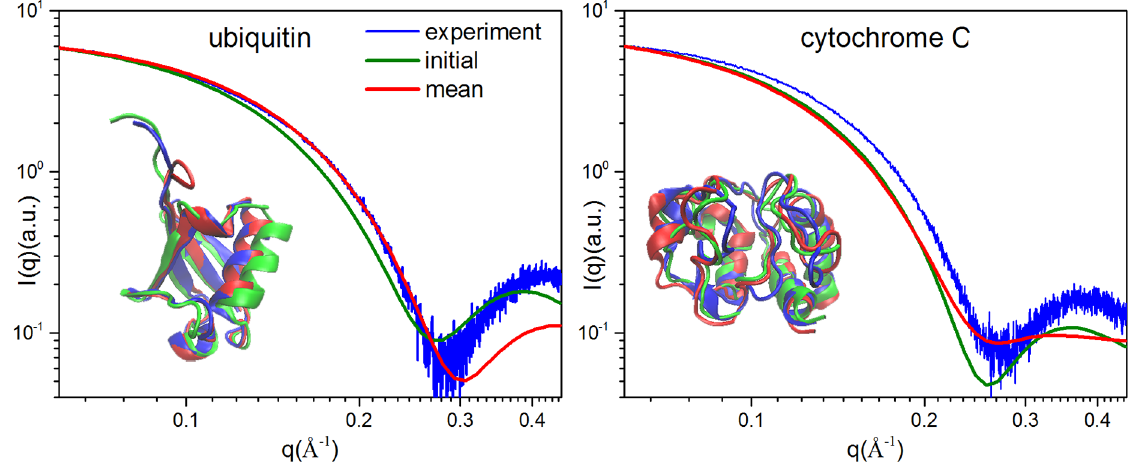
Fig 9. Structural and SAXS profiles comparison among initial (green), target (blue) and simulation (red) structures for ubiquitin and cytochrome C using experimental target SAXS profiles. The calculated SAXS profiles are the average of all 1,250 conformations in the last 5 ns of hybrid MD-MC